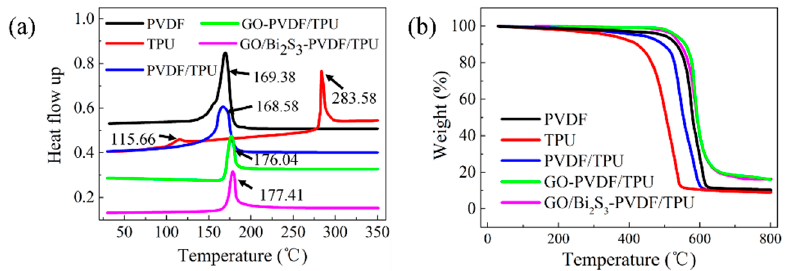
Figure 5. Differential scanning calorimetry (DSC) ( a ) and TG ( b ) of different membranes. Figure 5. Di ff erential scanning calorimetry (DSC) ( a ) and TG ( b ) of di ff erent